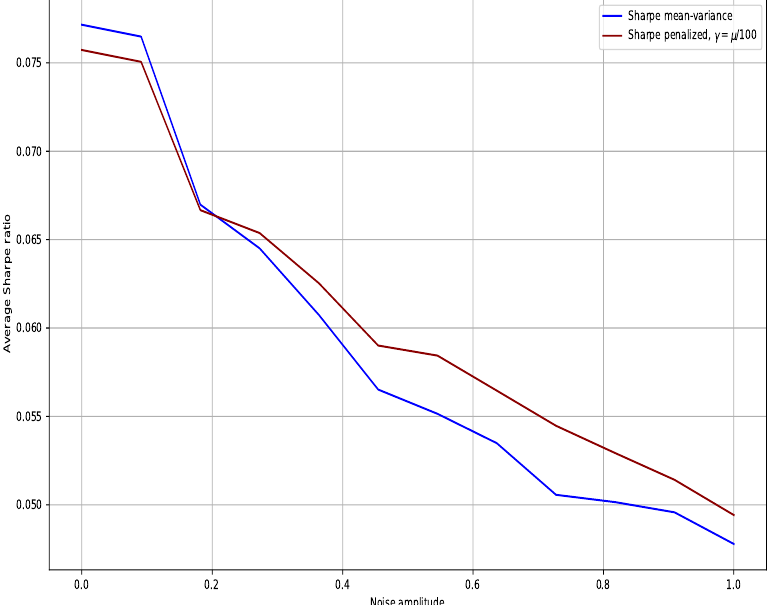
Figure 1. The highest average Sharpe ratio attained by the equal-weight portfolio is equal to 0.047 for (cid:101) =